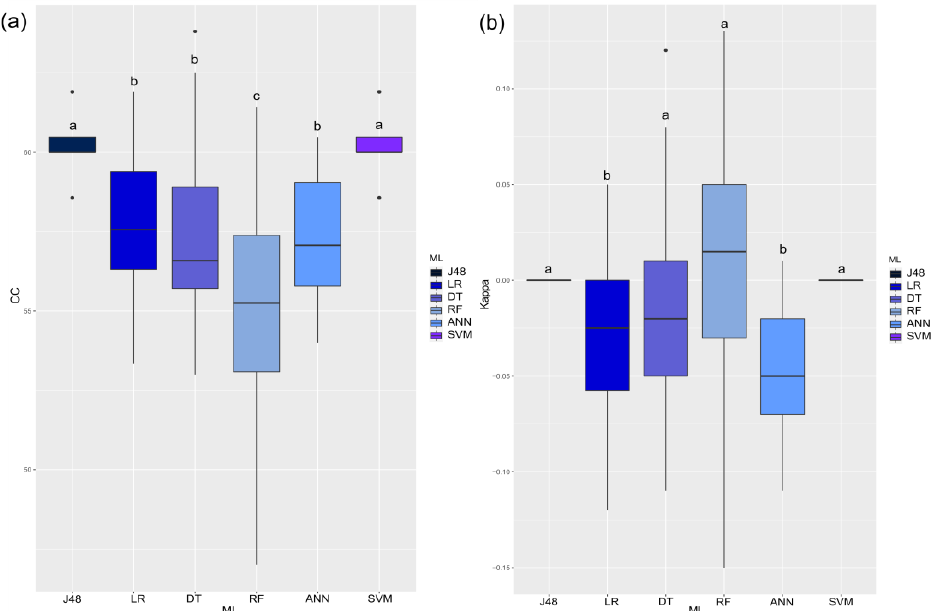
Figure 6. Boxplot of the clustering of means for percent correct classification–CC ( a ) and Kappa coefficient ( b ), regarding the machine learning models tested (J48 decision tree algorithm–J48, logistic regression–LR, REPTree decision tree algorithm–DT, random forest–RF, multilayer perceptron artifi- cial neural network–ANN, and support vector machine–SVM). Means followed by the same letters do not differ by the Scott–Knott test at 5%